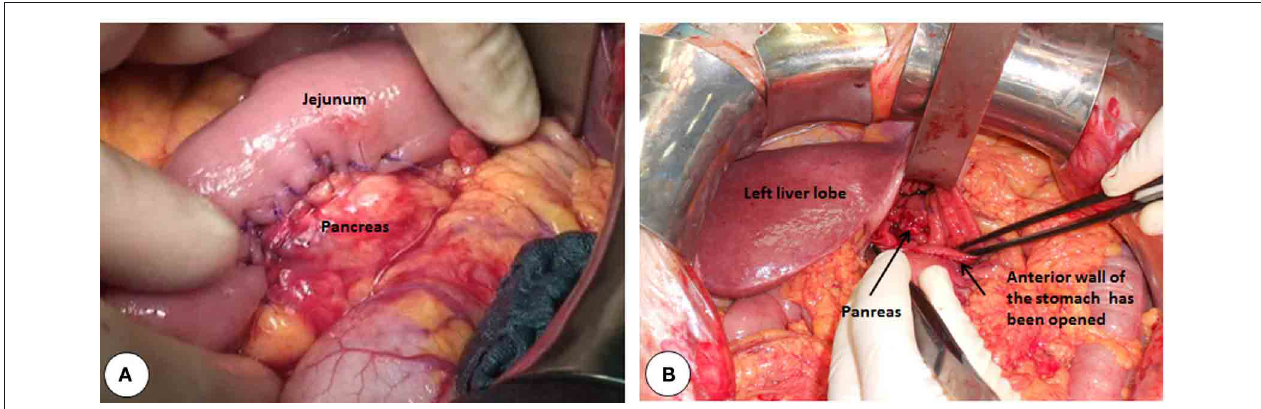
FIGURE 4 | Intraoperative pictures of various pancreatic anastomosis. (A) Pancreas is anastomosed to a diverted jejunal loop. (B) Pancreas is inserted in the posterior wall of the stomach. The anastomosis is made through a separate incision made on the anterior wall of the